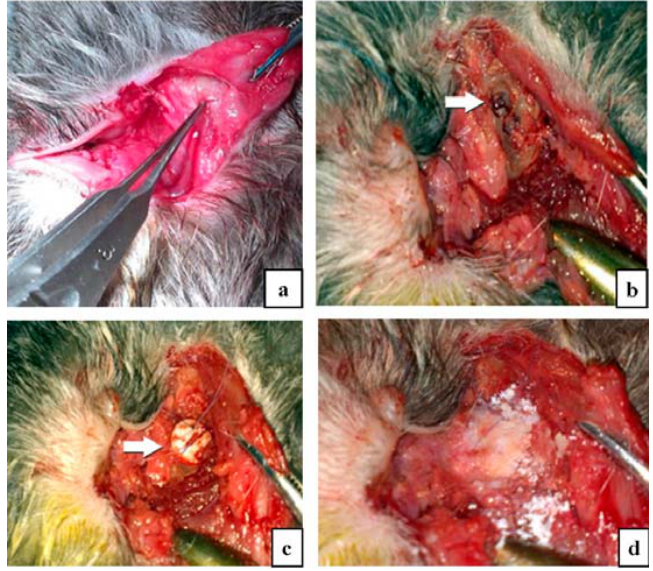
Figure 10. Intra ‐ operatory aspect: ( a ) transconjunctival approach and lateral cantothomy facilitate the inferior rim periosteal elevation; ( b ) the preformed osseous defect in the inferior orbital wall of 0.5 cm diameter (white arrow); ( c ) the orbital implant placed in the defect area and sutured to the periosteum; ( d ) the rest of the defect covered with hydroxyapatite powder.